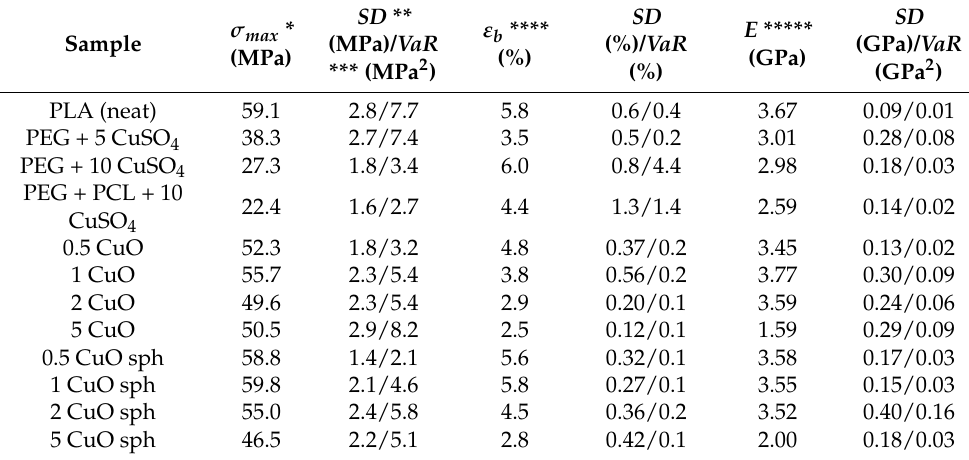
Table 3. Stress–strain properties of neat PLA and PLA-based composites. SD σ max * Sample (MPa)